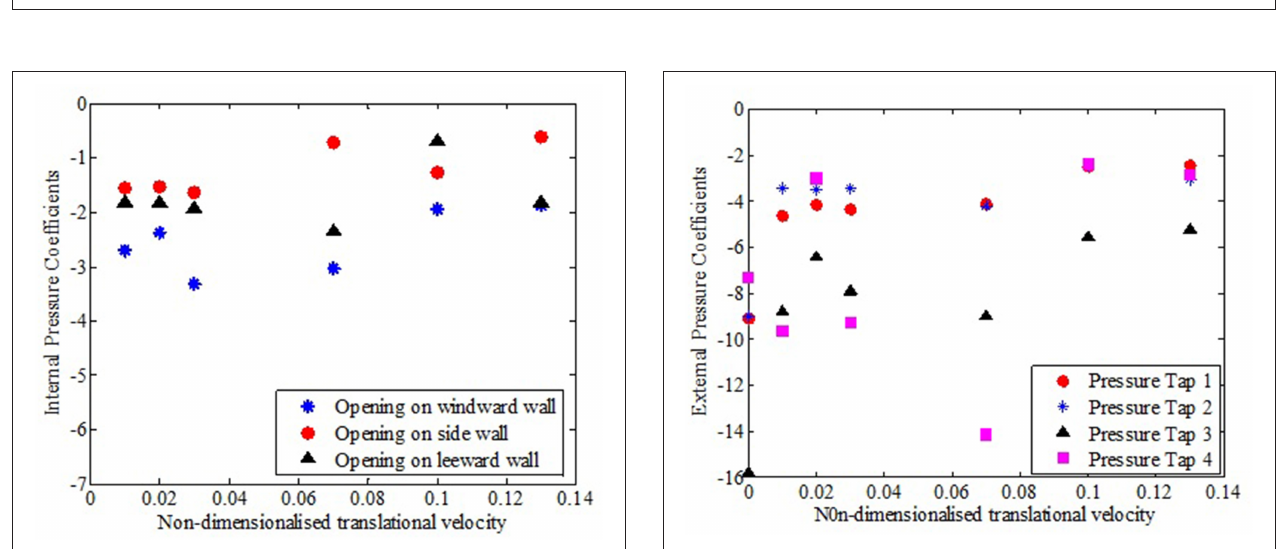
FIGURE 7 | Exploded view of the low-rise building model showing the pressure taps and the experimental model.